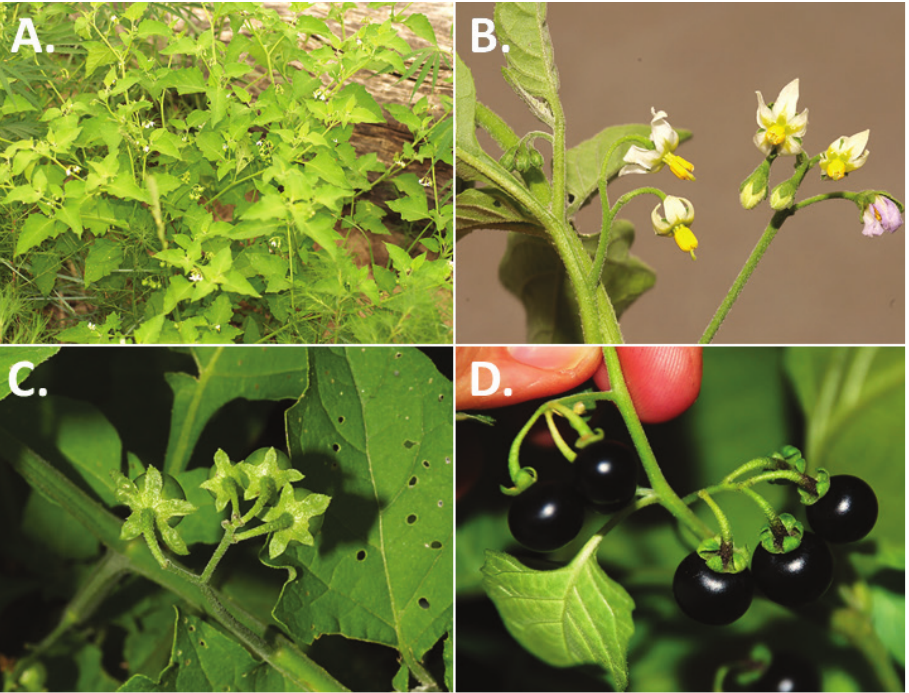
Figure 22. Solanum interius Rydb. A Habit B flowering branch C developing fruits D mature fruits ( A–C Nee 61350 ; D RBGE cultivated ). Photos by M. Nee and T.